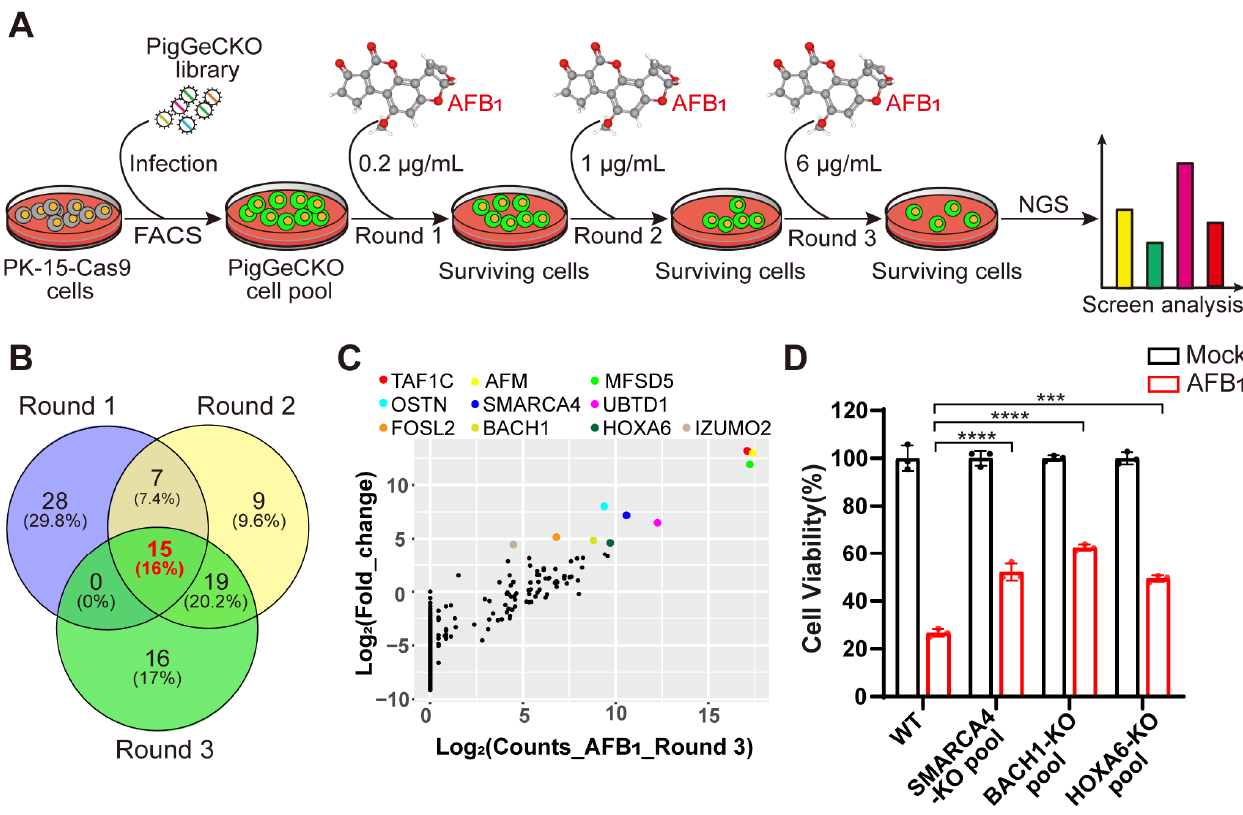
Figure 1. Genome-wide CRISPR/Cas9-based screening to identify genes involved in aflatoxin B 1 toxicity. ( A ) Strategy for CRISPR/Cas9-based aflatoxin B 1 (AFB 1 ) resistance screening. PK-15 cells expressing Cas9 (PK-15-Cas9) were transduced with a lentiviral PigGeCKO library to generate a pool of mutant cells (PigGeCKO cell pool). Mutant cells were then subjected to sequential rounds of exposure to AFB 1 at increasing concentrations (Round 1: 0.2 µ g/mL, Round 2: 1.0 µ g/mL, and Round 3: 6.0 µ g/mL). AFB 1 was refreshed daily until all control cells were killed. Surviving cells were harvested, and sgRNA sequences were identified by high-throughput sequencing. ( B ) Venn diagram of the top ~0.1% of shared and unique sgRNA target sequences obtained from each round of AFB 1 screening. ( C ) Scatter plots of the frequencies of sgRNA target sequence and the extent of enrichment in transformed PK-15-Cas9 cells in Round 3 of AFB 1 screening. ( D ) Cell viability assays for WT and KO cell pool of candidate genes after AFB 1 exposure at 2 µ g/mL for 36 h. *** p < 0.001, **** p < 0.0001. p values were determined with two-tailed Student’s t -tests. AFB 1 , aflatoxin B 1 ; FACS, fluorescence-activated cell sorting; NGS, next-generation sequencing; Round 1 (2 or 3), the first (second or third) round of AFB 1 challenge; WT, wild-type; KO, knockout. Subsequently, we selected 10 genes that appeared as top hits in Round 3 to test their effects on tolerance to AFB 1 (Figure 1C). Then, utilizing the CRISPR/Cas9 genome-editing system, we created KO mutants for the selected genes in PK-15 cells. Successful disruption of each gene was confirmed by Sanger sequencing (Figure S2). Quantification of AFB 1 - induced cell death in heterogeneous pools of three PK-15 KO cells indicated that KO induced cell death, with BACH1-deficient cells exhibiting the highest resistance (Figure 1D). Collectively, these results showed that several host factors were involved in AFB 1 -induced cell death and that BACH1 as the greatest outlier played a key role, leading us to select this target for further